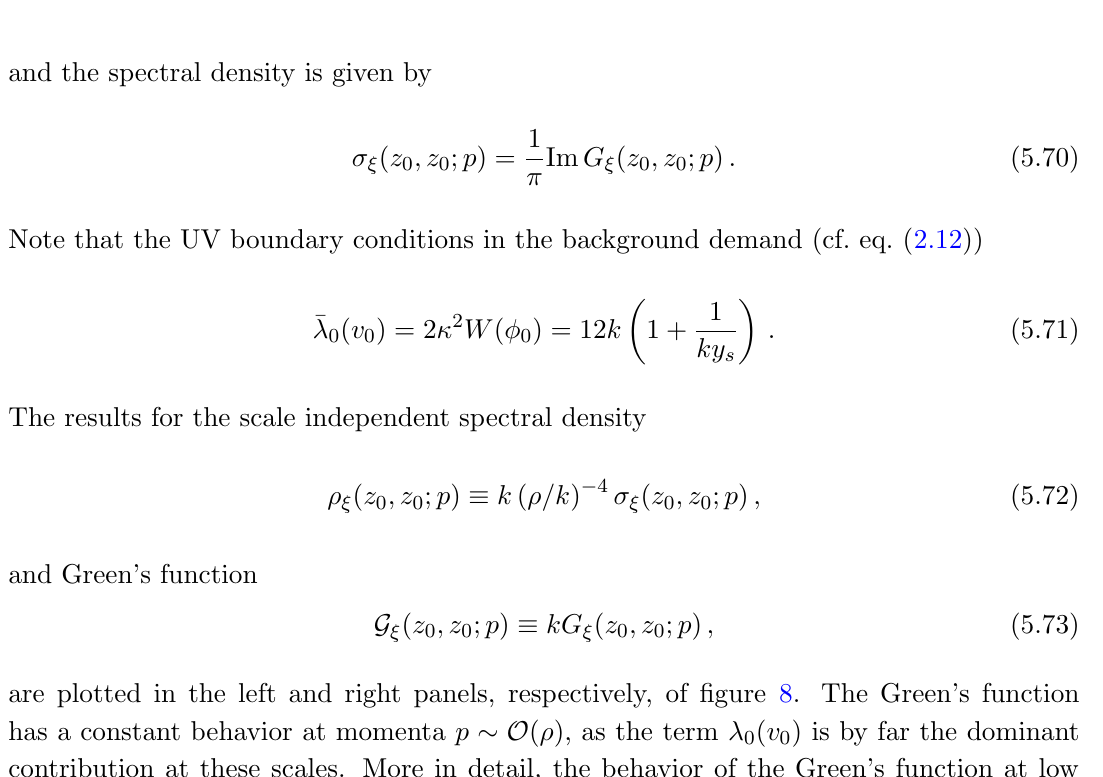
Figure 8 . Left panel: scale invariant spectral density for a continuum radion, as given by eq. (5.72). Right panel: scale invariant Green’s function for a continuum radion, as given by eq. (5.73). We have used A 1 = 35 and c =